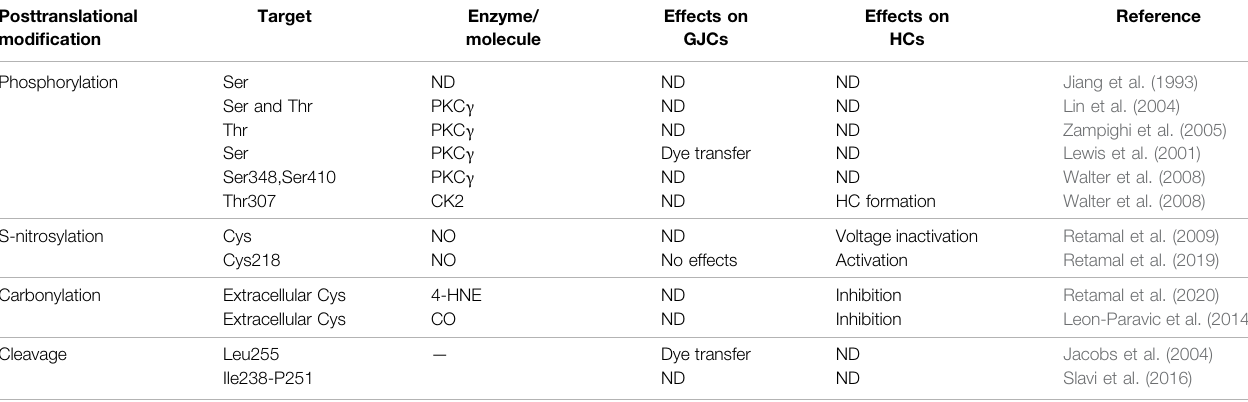
TABLE 1 | Posttranslational modi fi cations of